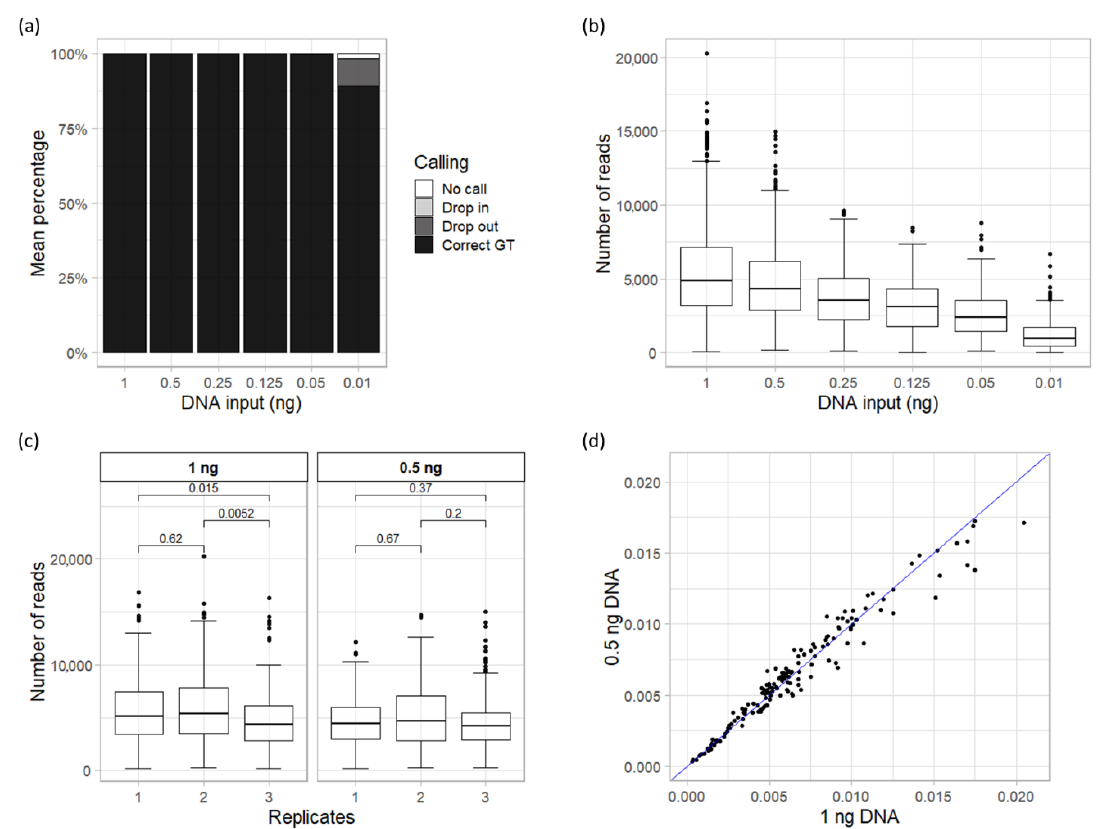
Figure 1. Results obtained with the VISible Attributes through GEnomics (VISAGE) Basic Tool for predicting appearance and ancestry (VISAGE BT A&A) (PSeq) assay for sensitivity and repeatability tests. ( a ) Mean percentage of correct genotypes and incorrect genotypes (drop-out, drop-in and no calls) obtained in the sensitivity test from the dilution series of 2800 M Control DNA (1 ng–10 pg) analyzed in duplicates. ( b ) Mean number of reads yielded per marker for each dilution step. ( c ) Average read depth per marker obtained in each replicate of 1 ng and 0.5 ng used for repeatability test. p -values of comparisons between replicates for Wilcoxon test are shown. ( d ) Mean normalized read depth per marker of 1 ng versus 0.5 ng replicates.